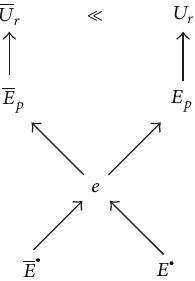
Figure 2: The causal structure of the RLS.